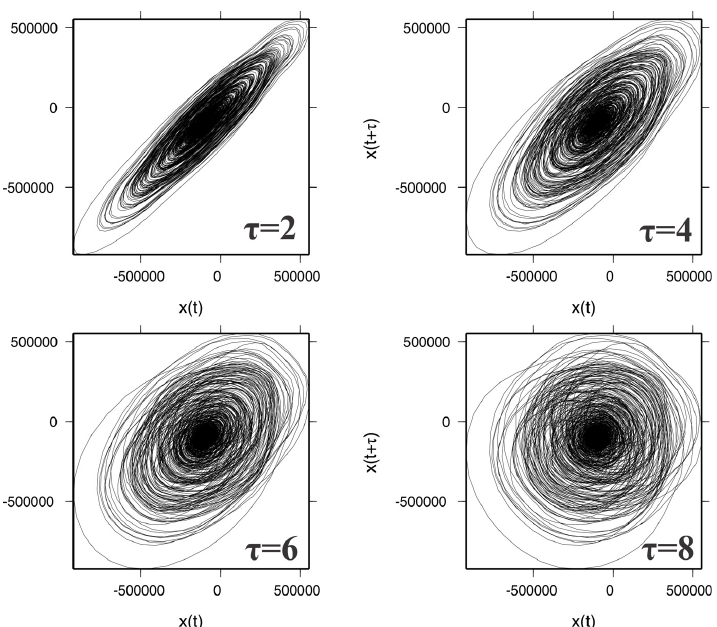
Fig. 5. Two-dimensional phase portraits of the volcanic tremor attractor for event #25 reconstructed using different delay